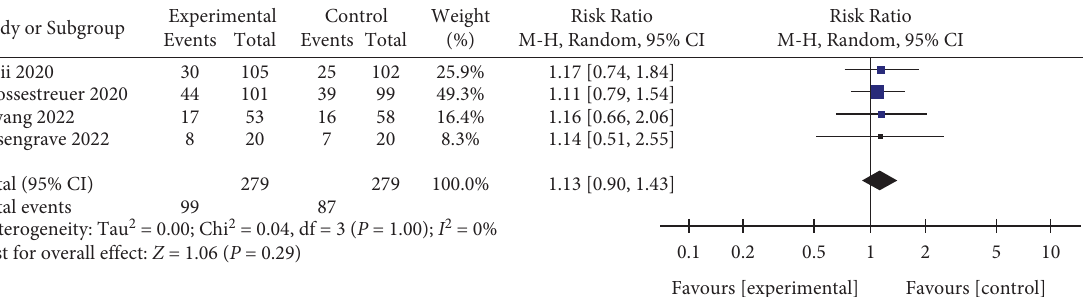
Figure 7: Forest plots for the efect of vitamin C on the 90-day mortality.